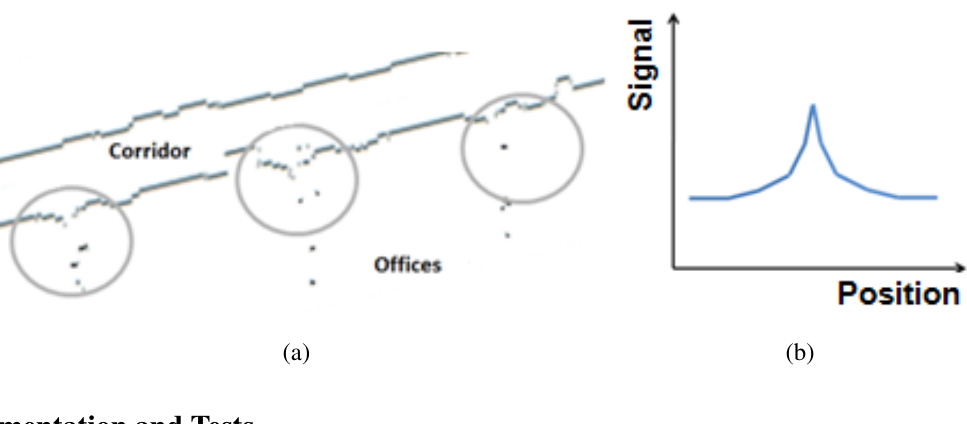
Figure 5. (a) Range data collected during a survey test in a corridor. Door frames are detected on one side, along with some posts; (b) Representation of the typical signature of a door